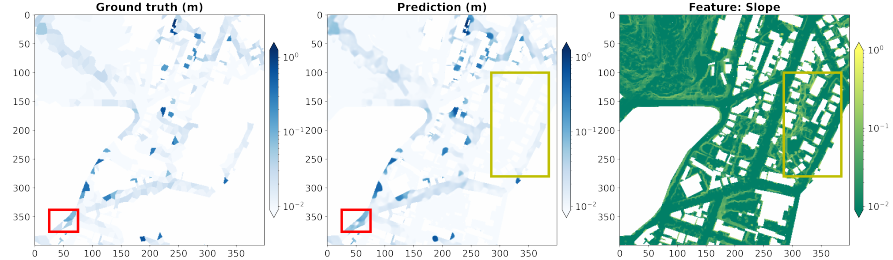
Figure 7. Ground truth maximum water depth and prediction for steep catchment at one specific time step of rainfall event tr2_1 , with a bounding box in red depicting the patch area shown in ( b ). In the bottom figure, we highlight in red the areas where the edges around water basins are smoothed out; in yellow, an area of the reconstruction which presents small